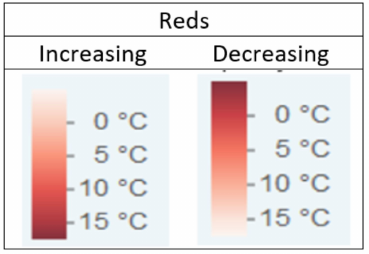
Figure 8. The order of colors for Reds color